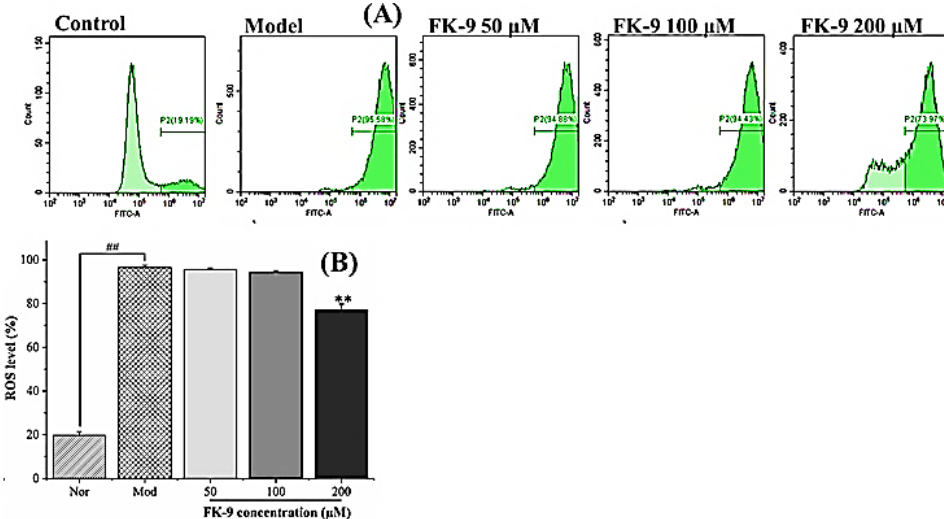
Figure 6. Effect of synthetic peptides on intracellular ROS content of HepG2. ## very significant ( p < 0.01) comparison between normal group and model group, ** very significant ( p < 0.01) comparison between peptide group and model group. ( A ) Flow cytometry (FITC-A) analysis of intracellular ROS, ( B ) Intracellular ROS content calculated by flurescent intensity in ( A ).